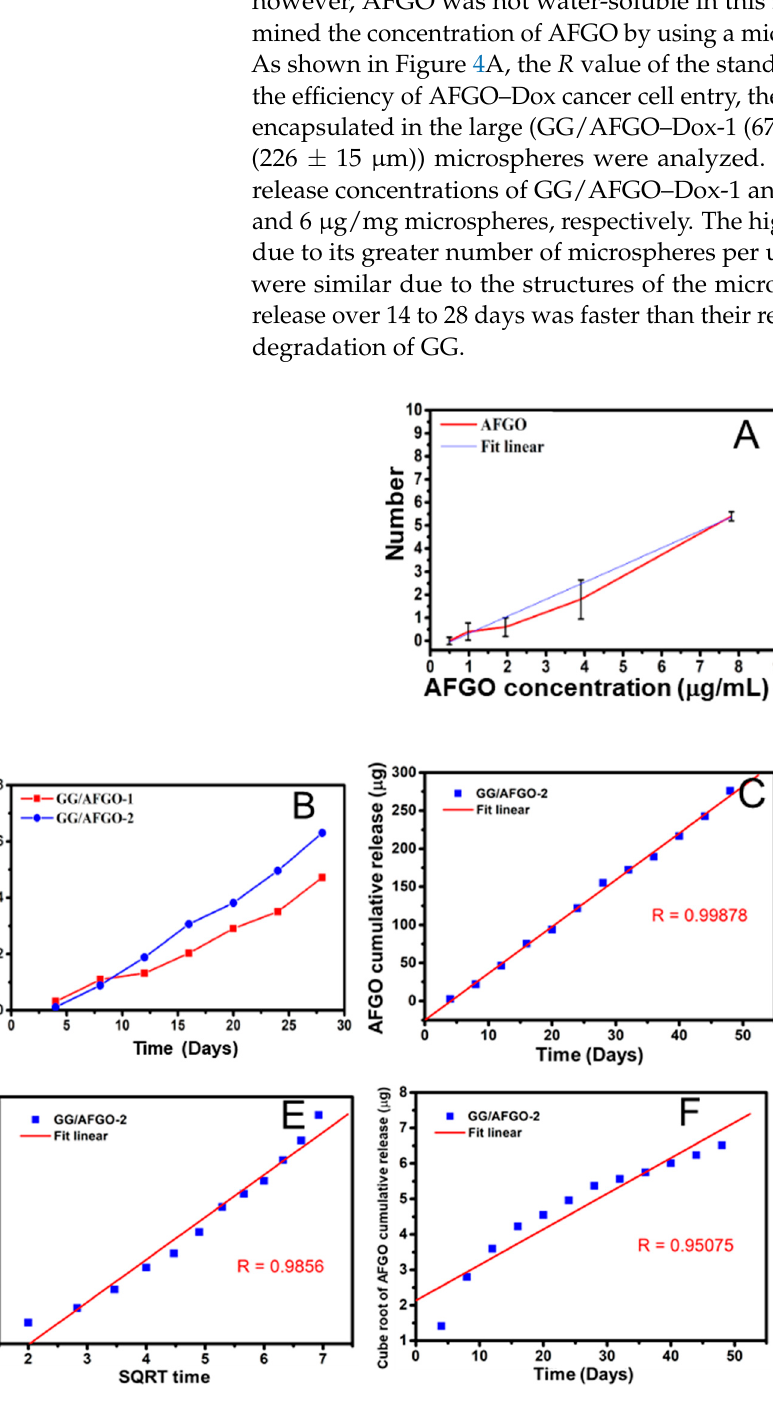
Figure 4. ( A ) Profile of AFGO release from GG/AFGO–Dox-1 (674 ± 43 μ m) and GG/AFGO–Dox-2 (226 ± 15 μ m) over 28 days. AFGO release according to the following kinetic models: ( B ) zero, ( C ) first, ( D ) Higuchi, ( E ) Hixson–Crowell and ( F ) Korsmeyer–Peppas.